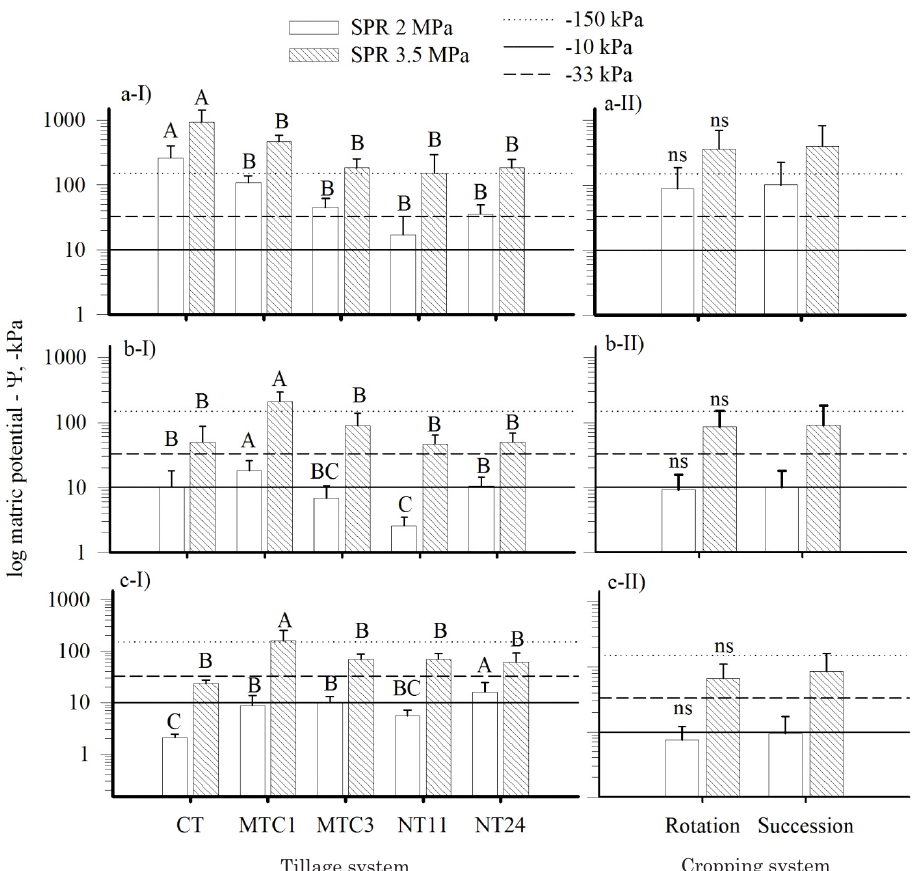
Figure 4. Soil water matric potential when the soil penetration resistance reaches 2 and 3.5 MPa in the layers 0.0-0.10 m (a); 0.10-0.20 m (b) and 0.20-0.30 m (c) for tillage (I) and cropping systems (II). Means followed by the same letter, uppercase between tillage systems, and lowercase in the same tillage or cropping system, do not differ by Tukey’s test (p<0.05). CT: conventional tillage; MT 1 : minimum tillage, annual chiseling; MT 3 : minimum tillage, chiseled every three years; NT 11 : no-tillage for 11 years; NT 24 : no-tillage for 24 years. Vertical bars indicate standard deviation from the